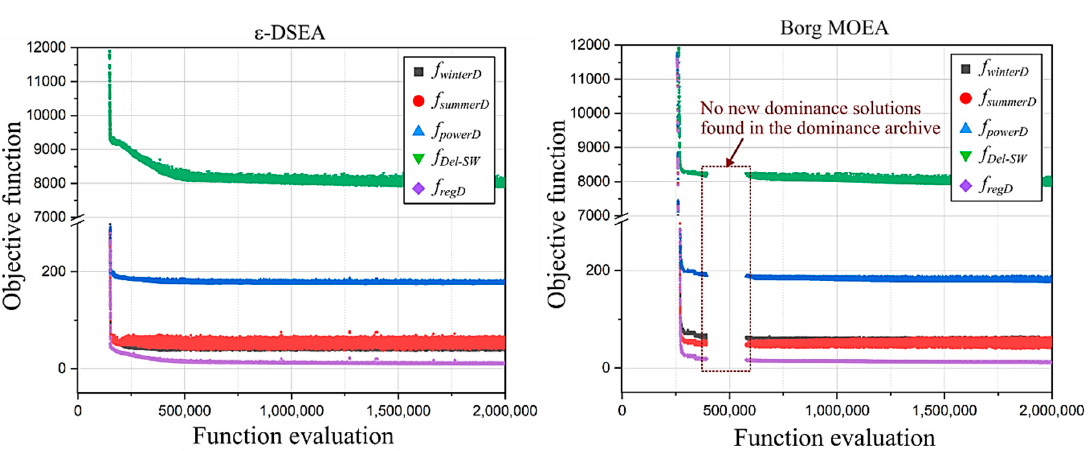
Figure 7. Convergence progress during evaluation process of both algorithms for trial no.